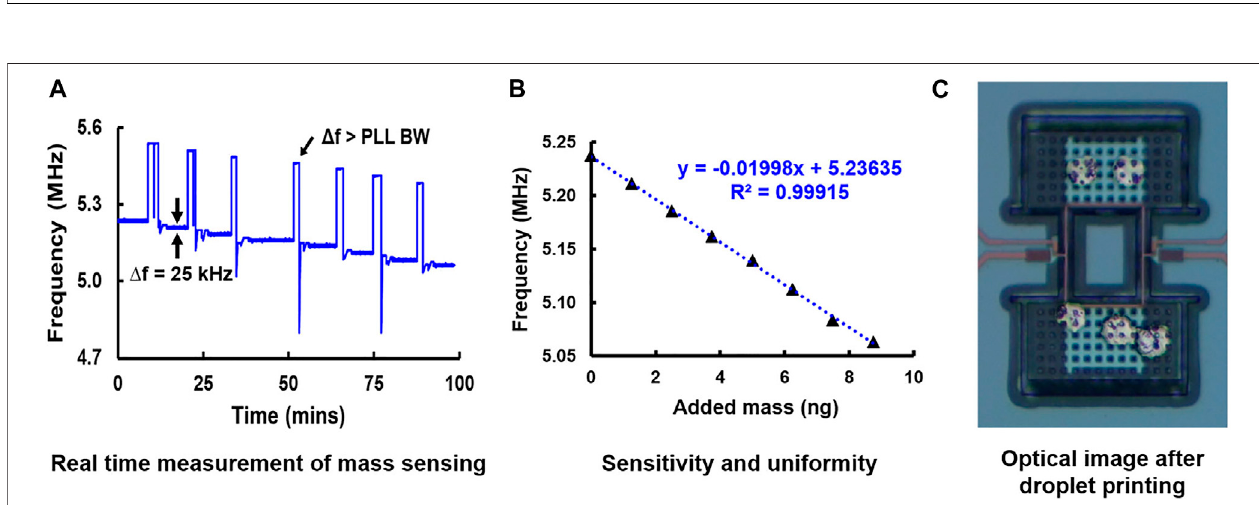
FIGURE10| OscillatorperformanceevaluationofII-bar(blue)andCCB(brown). (A) Phasenoiseresponseshowingfar-from-carriernoiseof − 100 dBc/HzforCCB and − 76 dBc/Hz for II-bar. (B) Frequency stability evaluation, showing Allan deviation of 72 and 85 ppb for CCB and II-bar, respectively, in air.